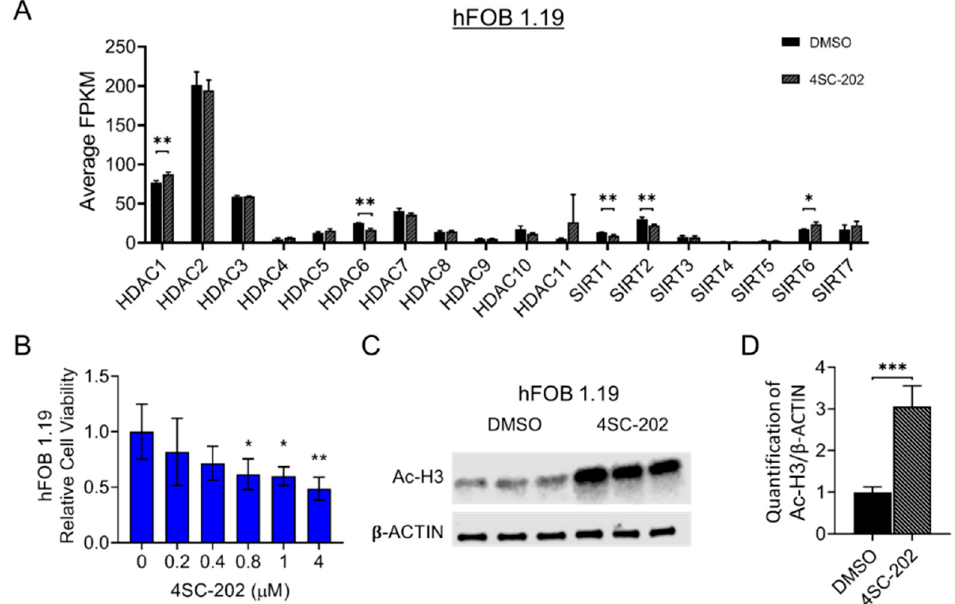
Figure 2. Impact of selective pharmacological inhibition of class I histone deacetylases with 4SC-202